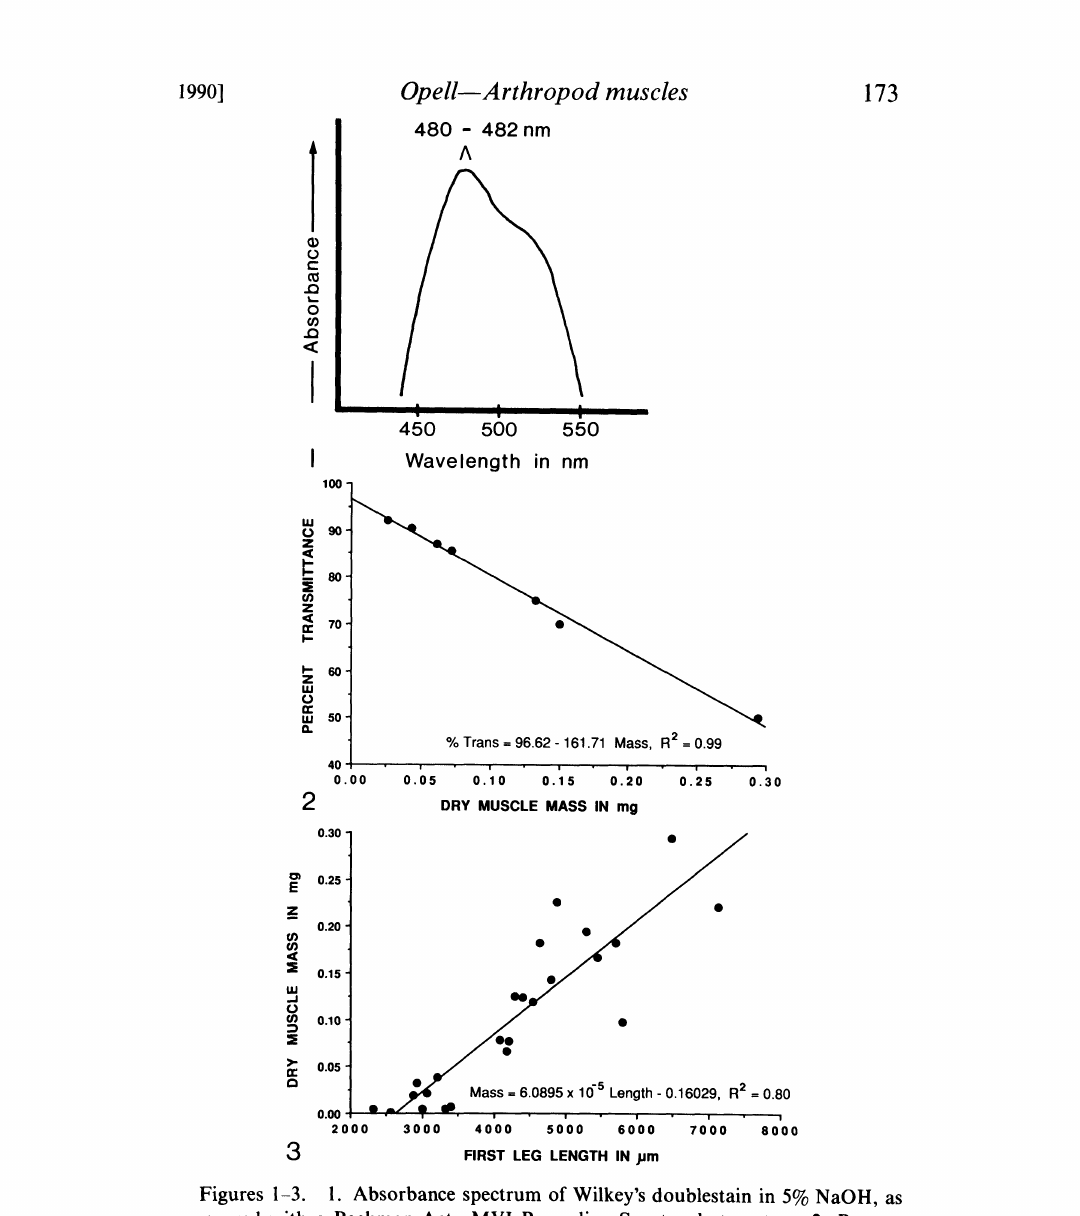
Figures 1-3. 1. Absorbance spectrum of Wilkey’s doublestain in 5% NaOH, as measured with a Beckman Acta MVI Recording Spectrophotometer. 2. Regres- sion of the dry mass of stained Octonoba sinensis leg muscles and their percent transmittance of 480 nm light after being digested in NaOH. 3. Regression of the combined muscle mass of the two first legs of Miagrammopes pinopus and first leg